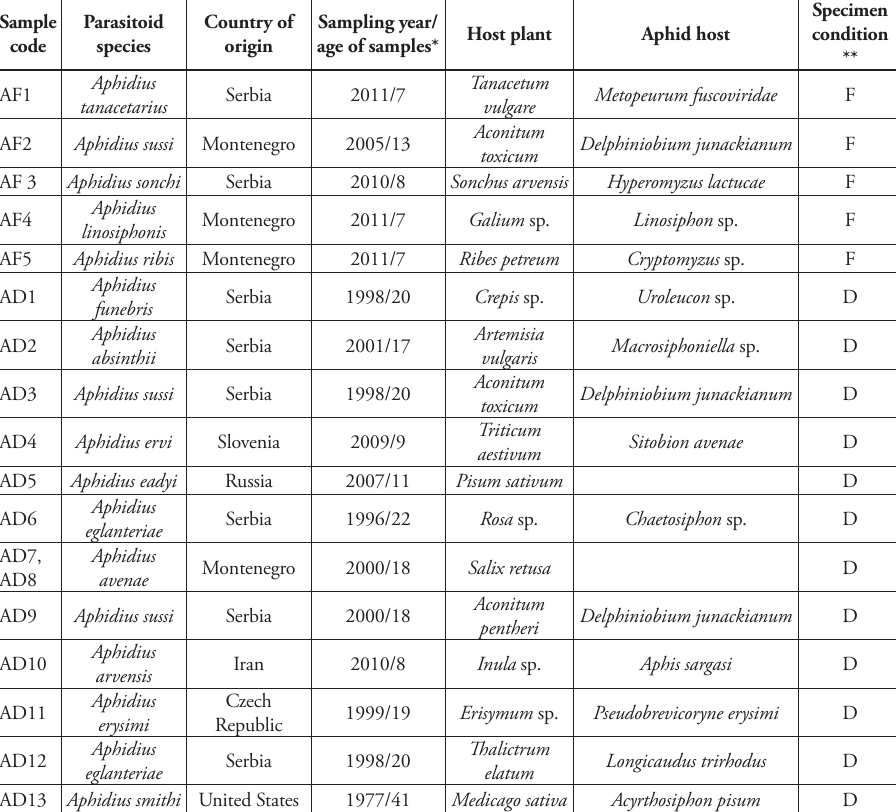
Table 1. The list of analyzed species from the genera Aphidius , Lysiphlebus , Praon , Ephedrus , Monoctonus with designated aphid host/plant associations and geographic